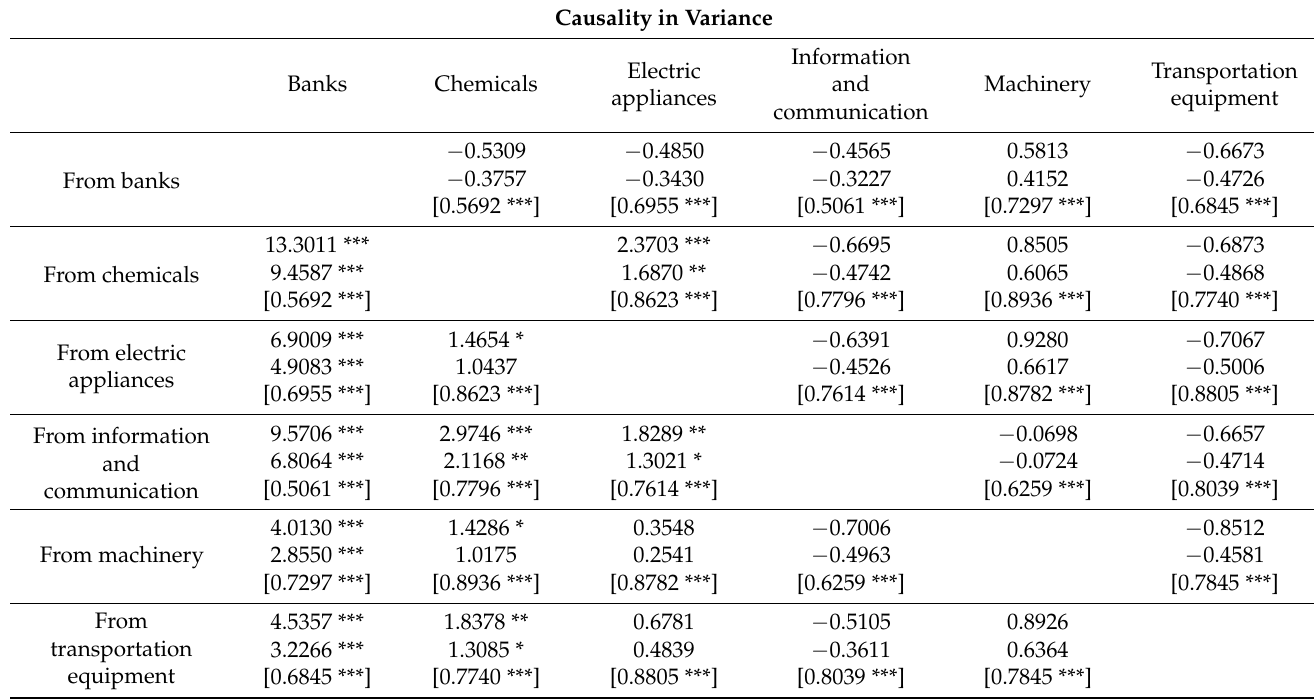
Table 7. Causality relationship among sectoral indices. Author’s estimations. First line reports Hong’s (2001) Q-statistics with truncated kernel. Second line reports Hong’s (2001) Q-statistics with Bartlett kernel. Third line reports cross-correlation coefficients at lag 0 (contemporaneous correlation). ***, ** and * indicate that the null hypothesis of no causality (from lag 1 to lag 10 for Hong’s (2001) Q-statistics) at the 1%, 5%, and 10% significance levels, respectively, is rejected.